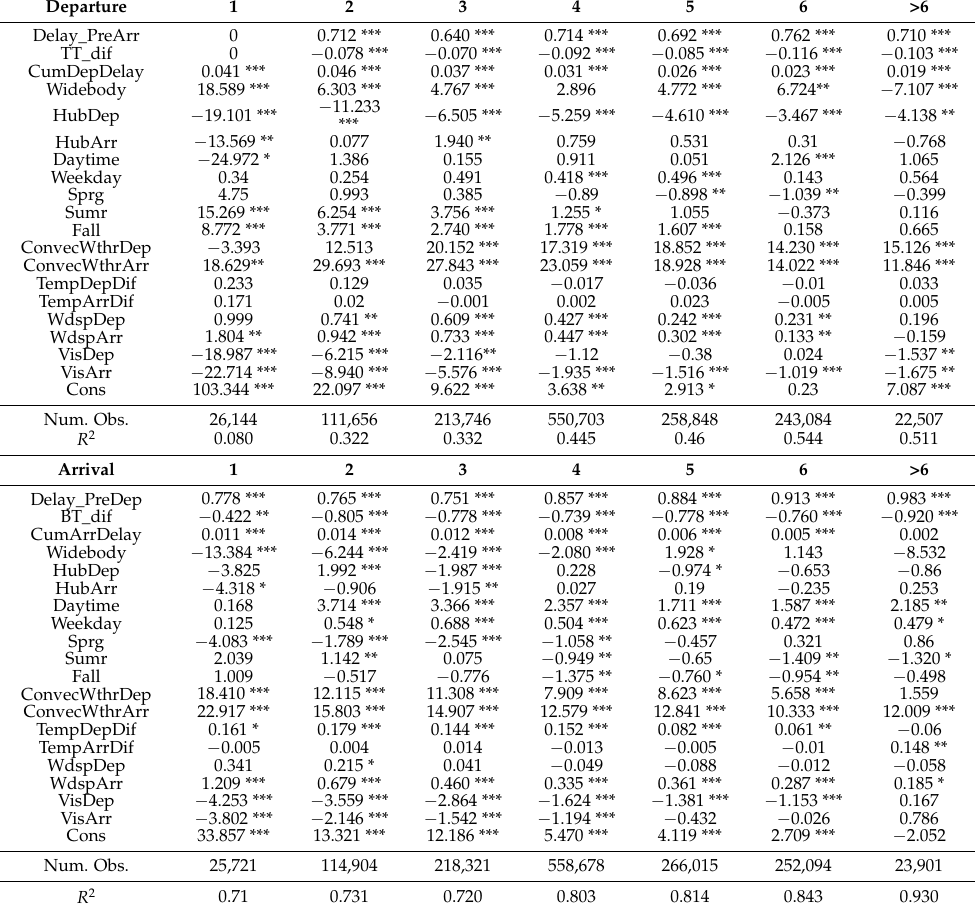
Table 5. Estimation results of flight delays for departure and arrival in different